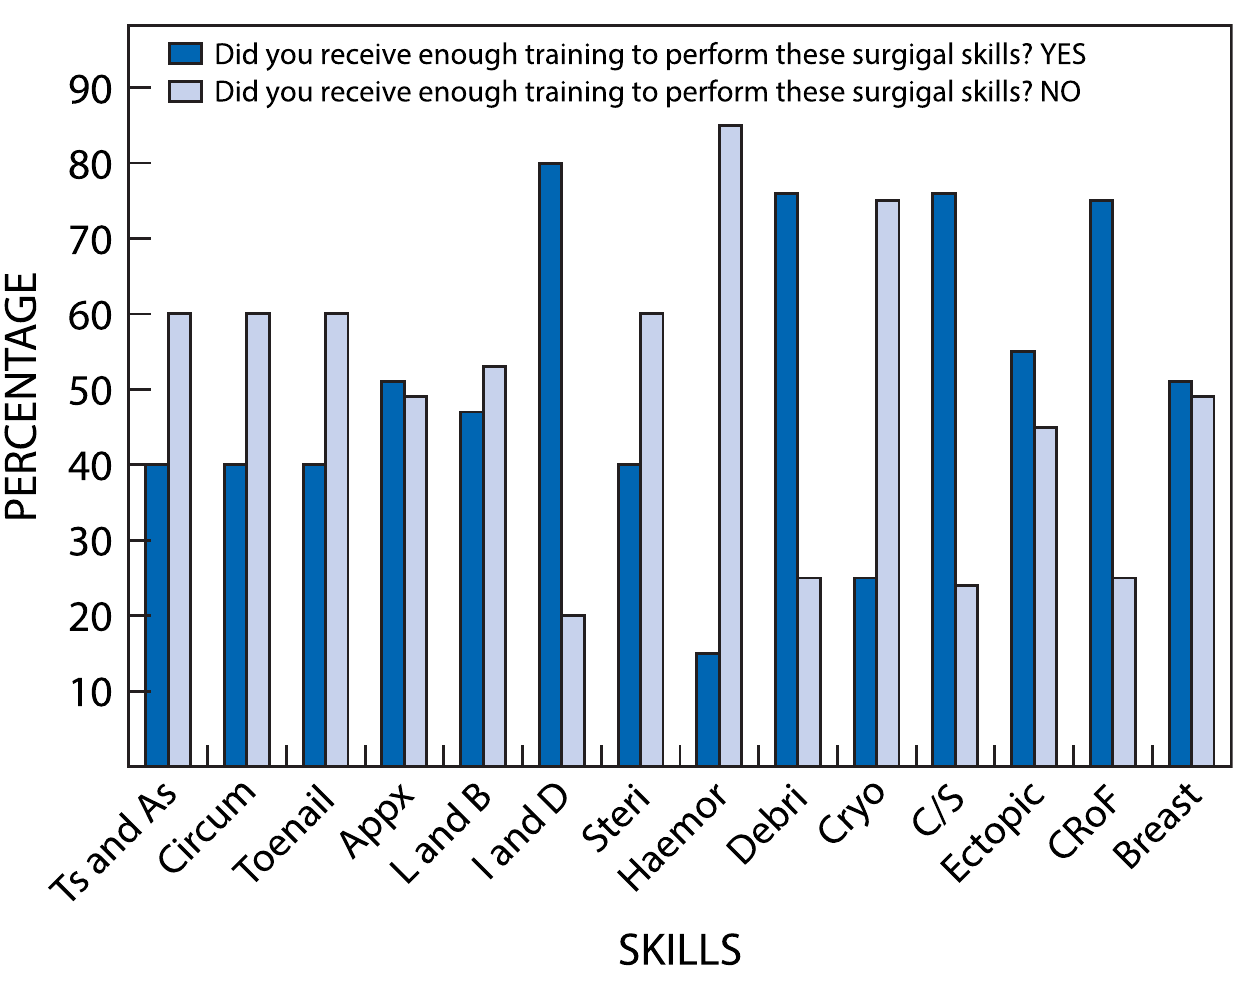
Appx: appendectomy, Breast: breast tumour bioposy, Circum: circumcision, C/S: Caesarean section, Cryo: cryotherapy of dermatological conditions, Debri: debridement of wounds, Ectopic: ectopic pregnancy surgery, GPs: general practitioners, Haemor: haemorrhoidectomy, I and D: incision and drainage, L and B: lumps and bumps, Steri: sterilisation, Toenail: wedge resection of big toenails, Ts and As: Tonsils and Figure 2: Interns’ reports on whether or not they received training in surgical skills